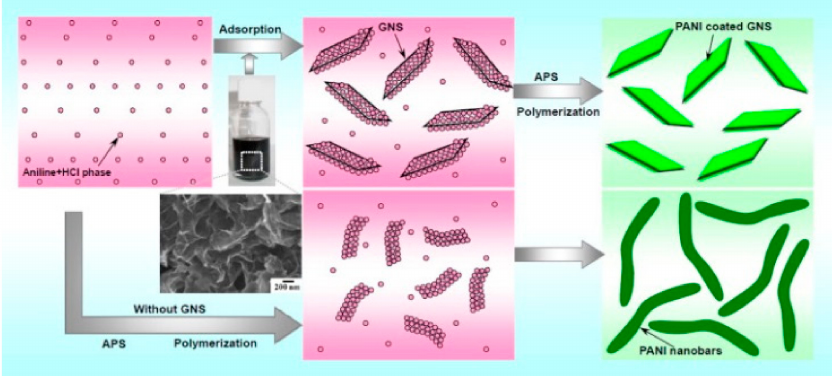
Figure 7. In-situ polymerization for manufacture of GRPCs. Reproduced with permission from [108]. Copyright 2010,